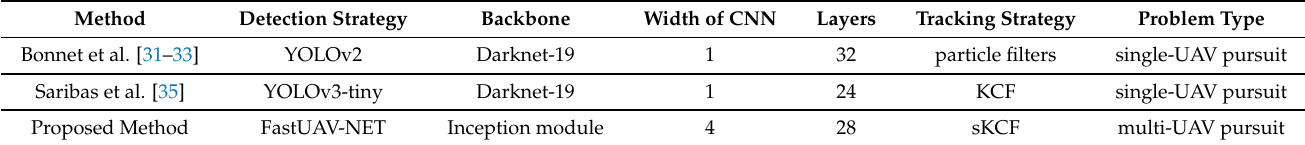
Table 1. A comparative overview of UAV-UAV detection and tracking